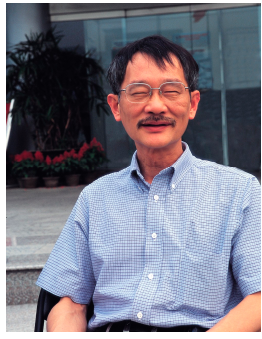
Figure 1. Academician Xiaowen Li.